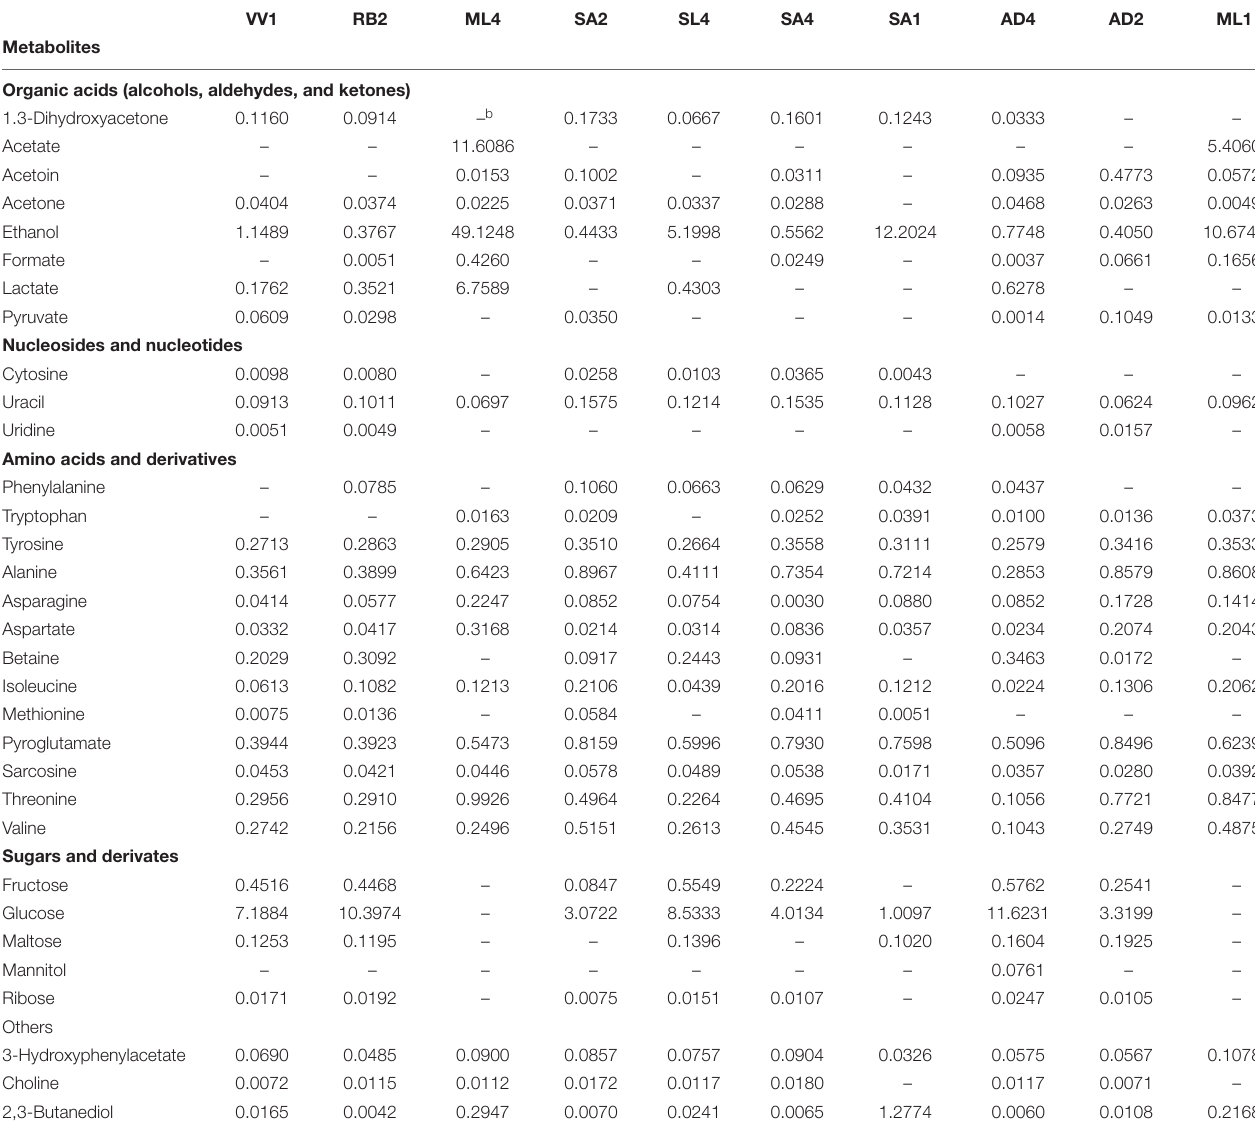
TABLE 3 | Quantification of metabolites detected by 1 H-NMR of the ten cell-free supernatants produced by Lactobacillus spp. grown in MRS with glycerol (20% v/v) expressed as mmoL.